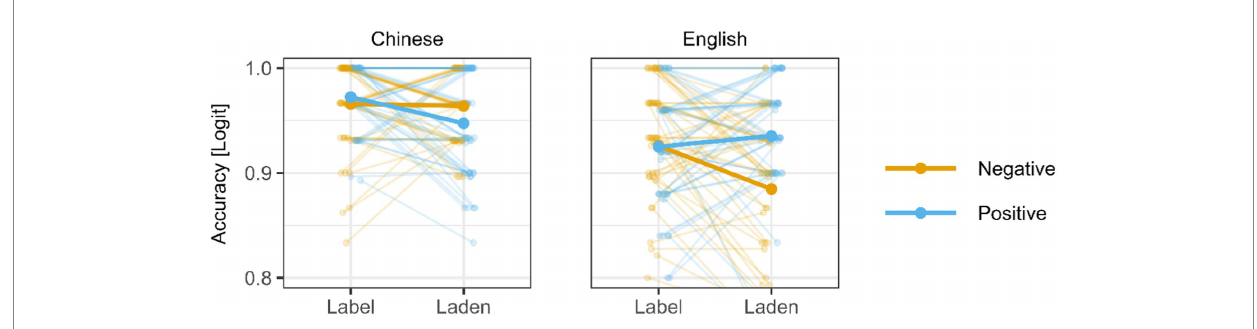
FIGURE 1 Triple interaction between valence (in color), language (L1 on the left, L2 right), and emotion word type (emotion-label and emotion-laden; on the x axis) reflected in ACCs (on the y axis). Single-subject indices (thin lines) are overlayed by group averages (thick